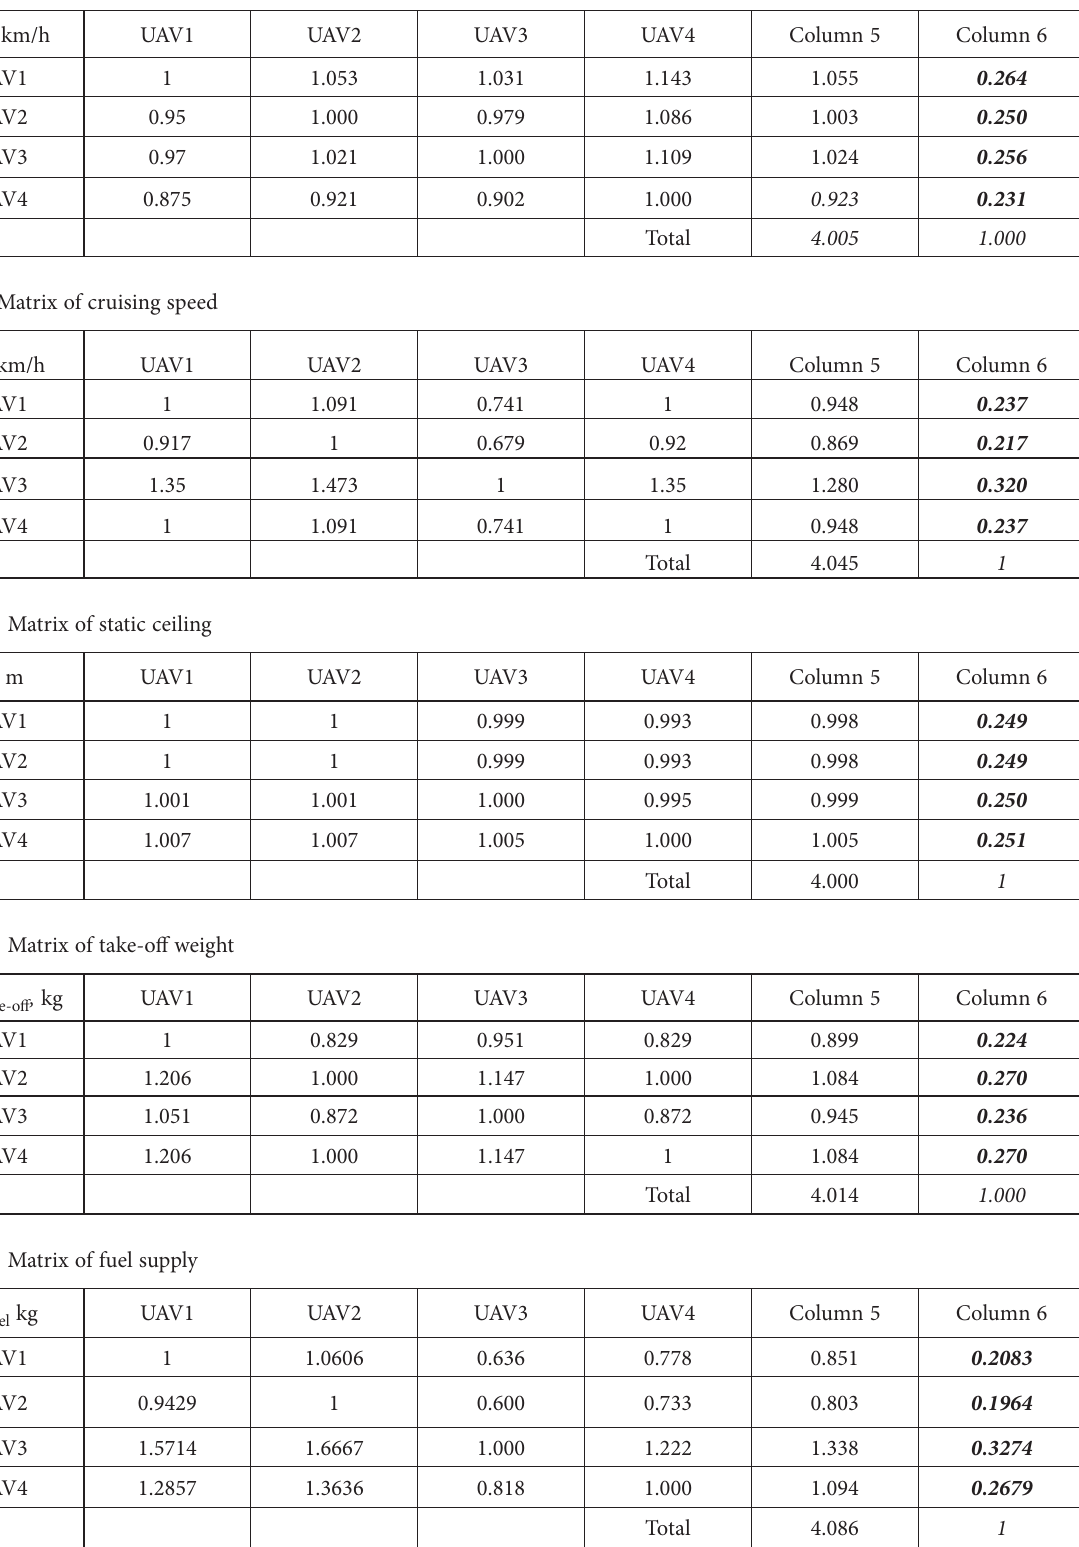
Table 8. Matrix of maximum speed